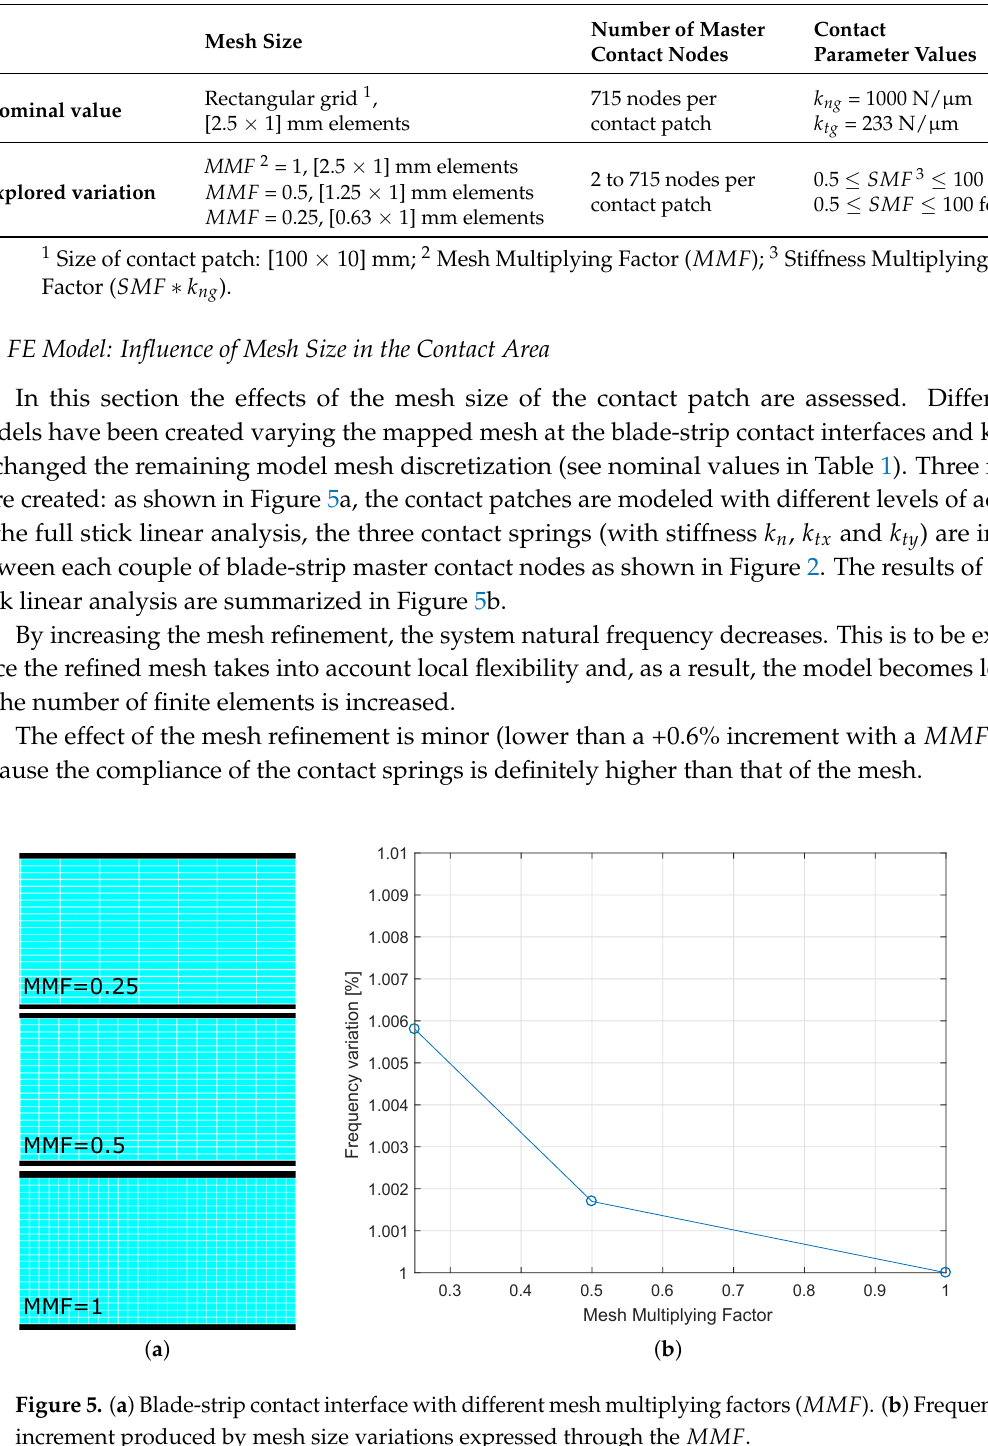
Table 1. Definition of “nominal” key modelling choices and investigated variations.